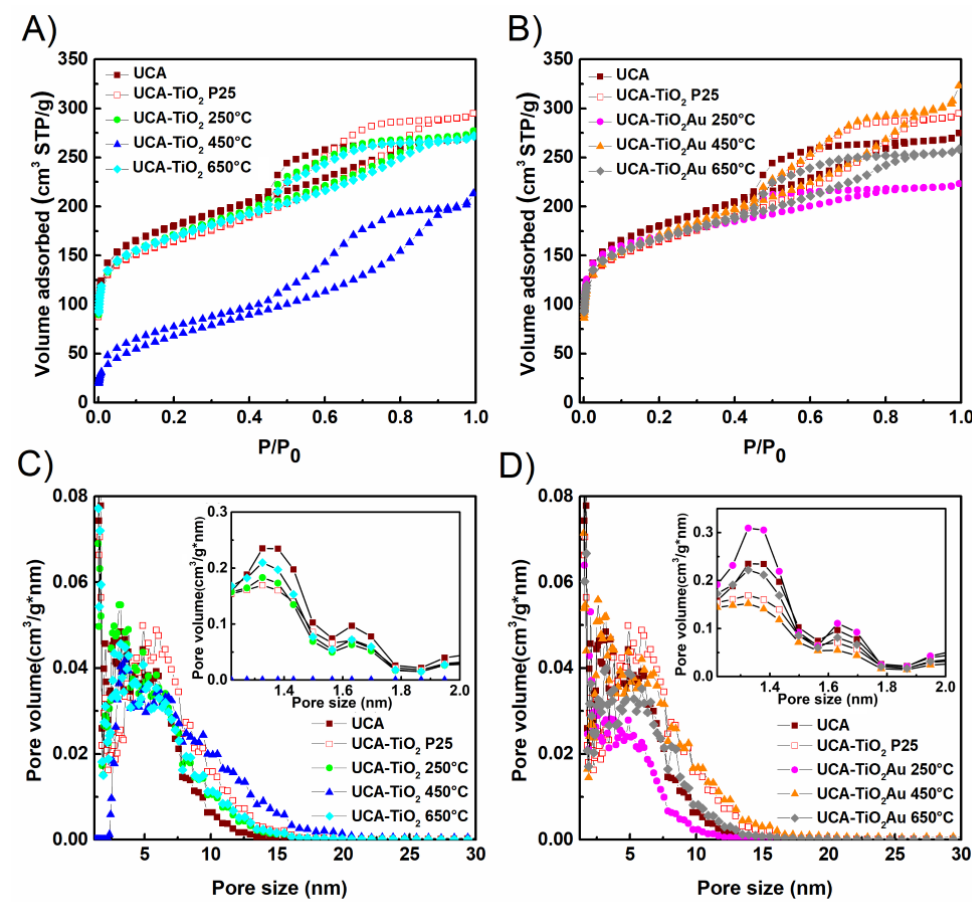
Figure 4. Nitrogen adsorption–desorption isotherms for the nanocomposite coatings under study: ( A ) UCA–TiO 2 series, ( B ) UCA–TiO 2 Au series. NLDFT pore size distribution are shown in ( C , D ), respectively.